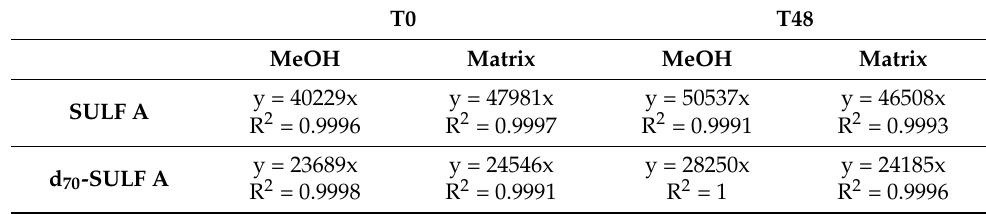
Figure 4. Calibration curve of d 70 -Sulfavant A ( a ) and Sulfavant A ( b ). Table 2. Calibration curve of d 70 -Sulfavant A and Sulfavant A at T0 and T48, both in MeOH and in matrix.